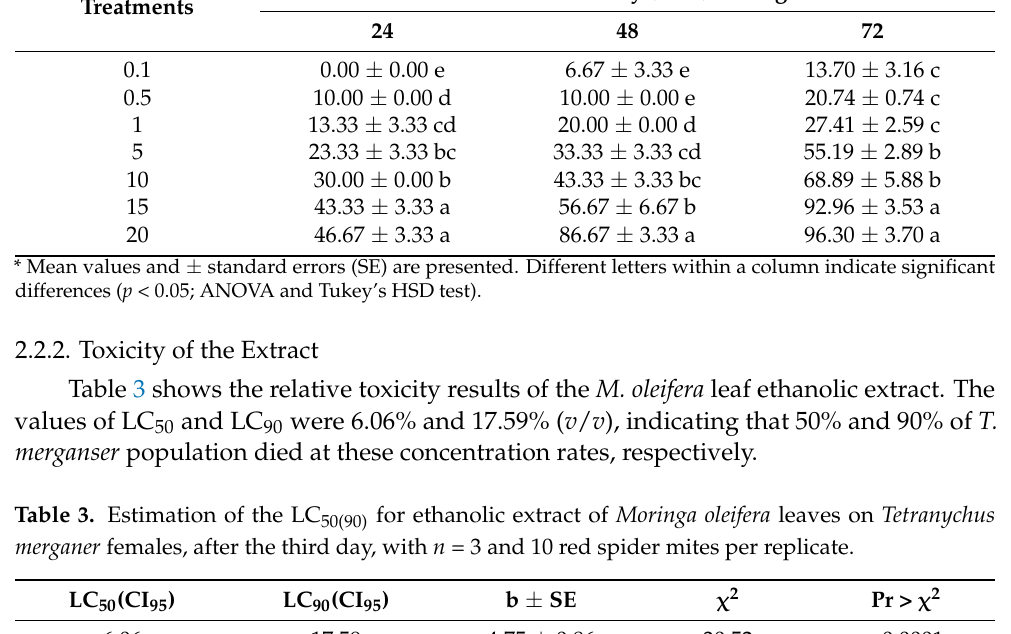
Table 4. Effects of Moringa oleifera leaf ethanolic extract on oviposition and the growth rate of Tetranychus merganser . Concentrations (% v / v )